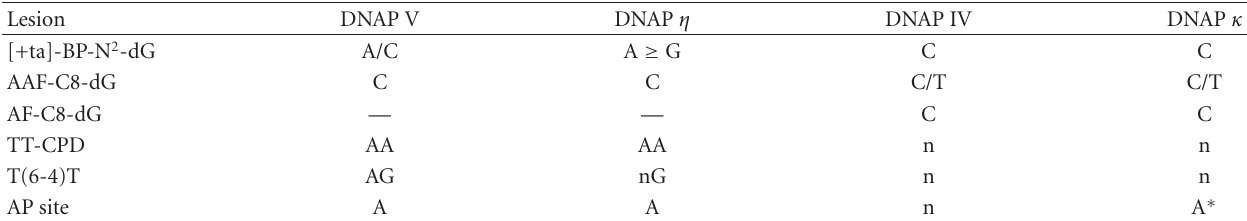
Lesion DNAP V DNAP η DNAP IV DNAP